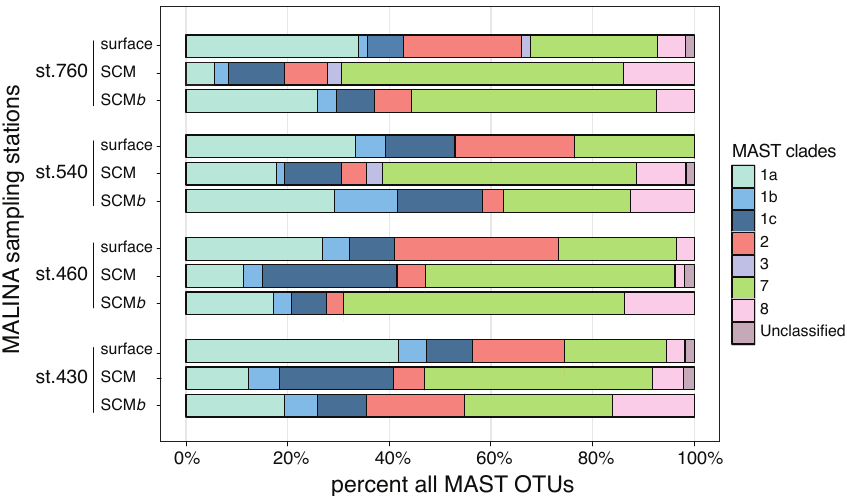
Fig. 4. Overall MAST OTU distributions across Beaufort Sea samples. OTUs (clustered at ≥ 98% sequence identity) were taxonomically classified using an in-house curated sequence database based on NCBI taxonomy. The distributions of each sample in distinct MAST sub- clades are displayed according to the color